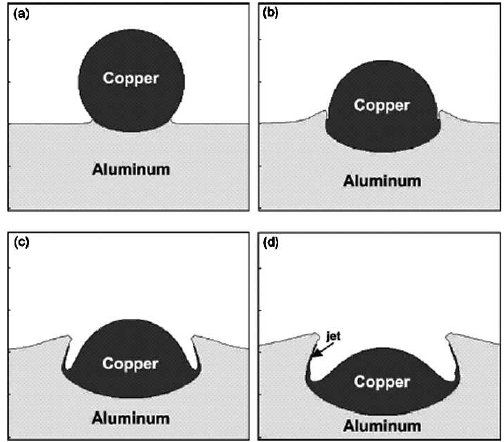
Figure 4: Impact of a Cu particle on a Cu substrate at successive times:(a)5 ns, (b)20 ns, (c)35 ns, (d)50 ns